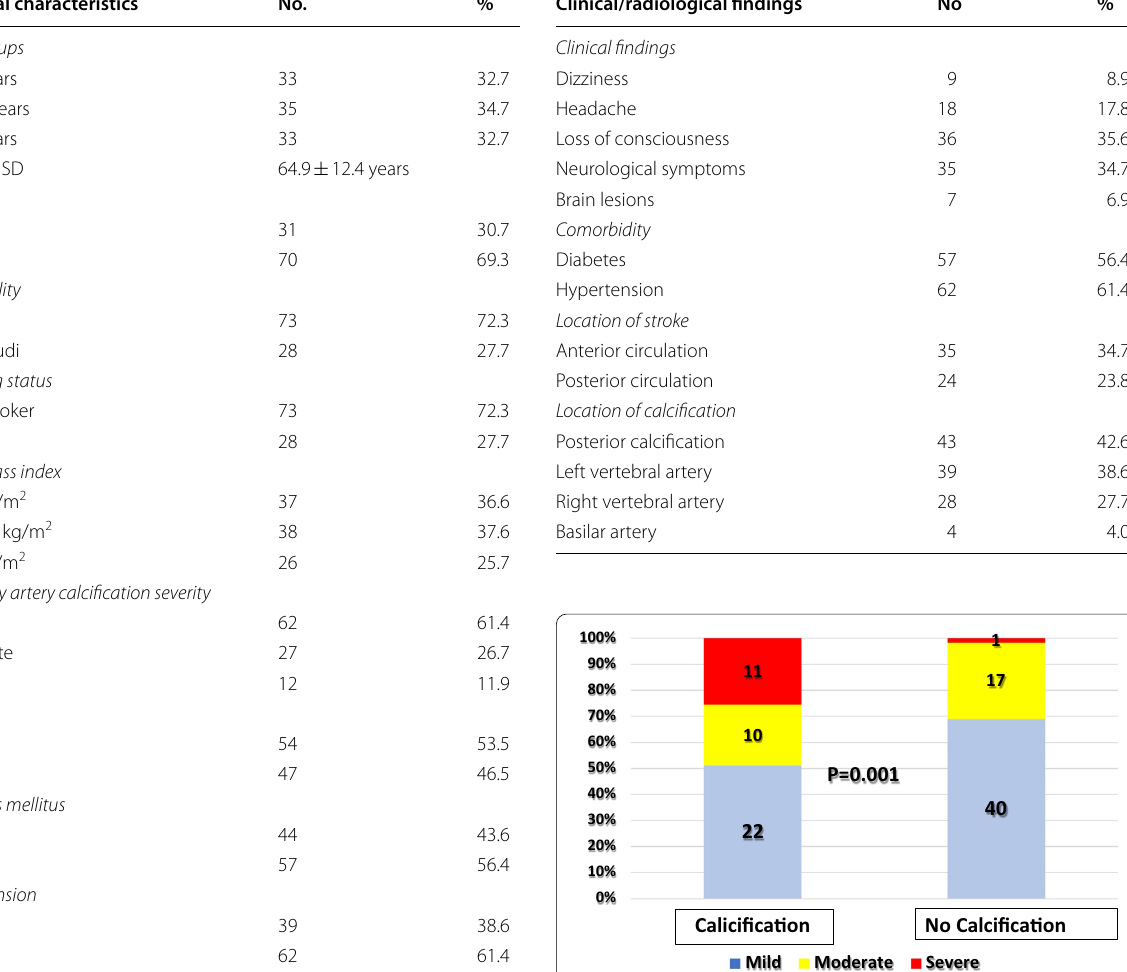
Fig. 3 Grades of coronary artery calcification according to presence of posterior circulation calcification